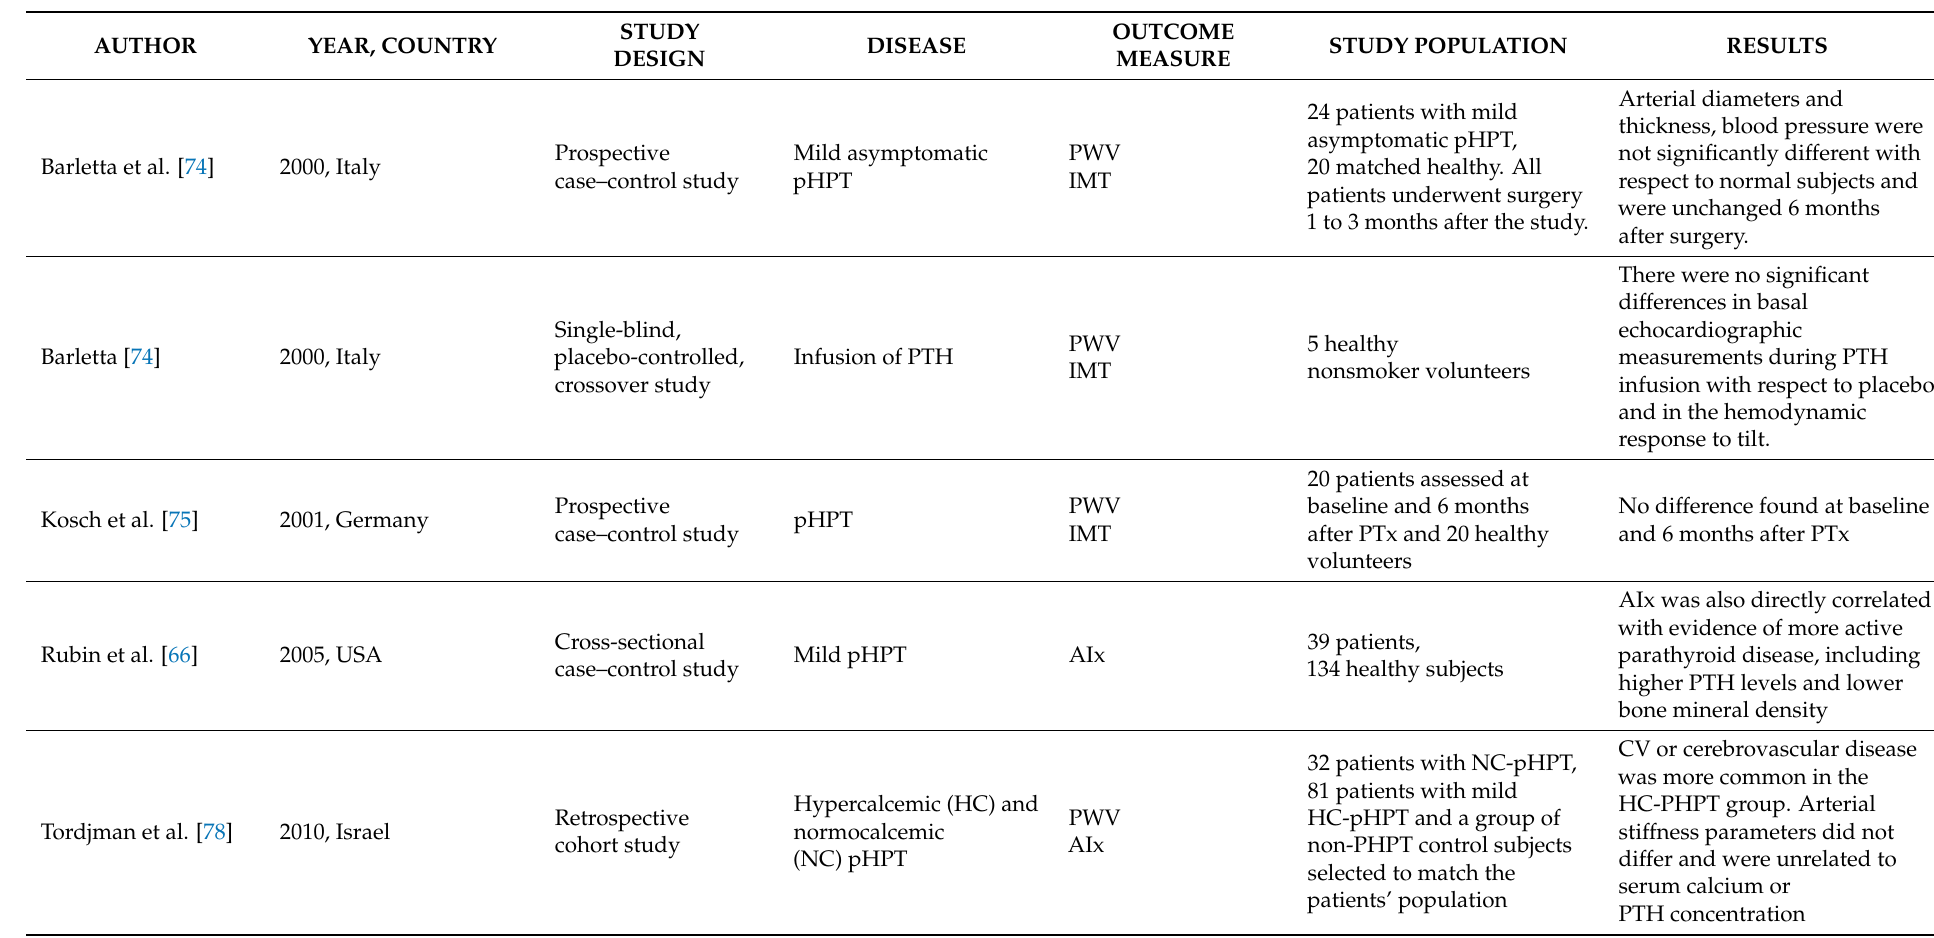
Table 3. Experimental studies evaluating arterial stiffness and parathyroid disease in